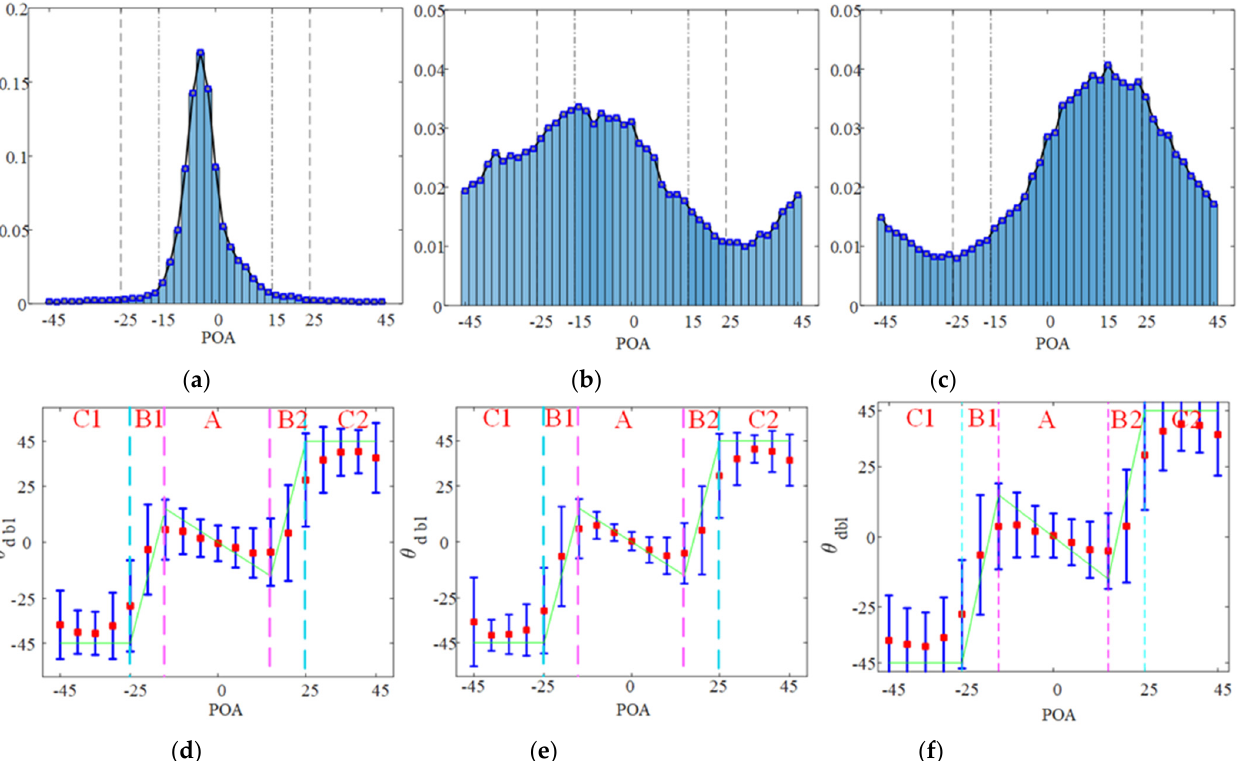
Figure 2. The histogram of POA and error bar plots of the relationship between POA and DBOA with airborne PiSAR data. ( a – c ) are the statistical distribution of POA for three different patches. ( d – f ) are the error bars. The red dots and blue error bars represent mean value and stand deviation of θ dbl . The green lines are the piecewise linear fitting